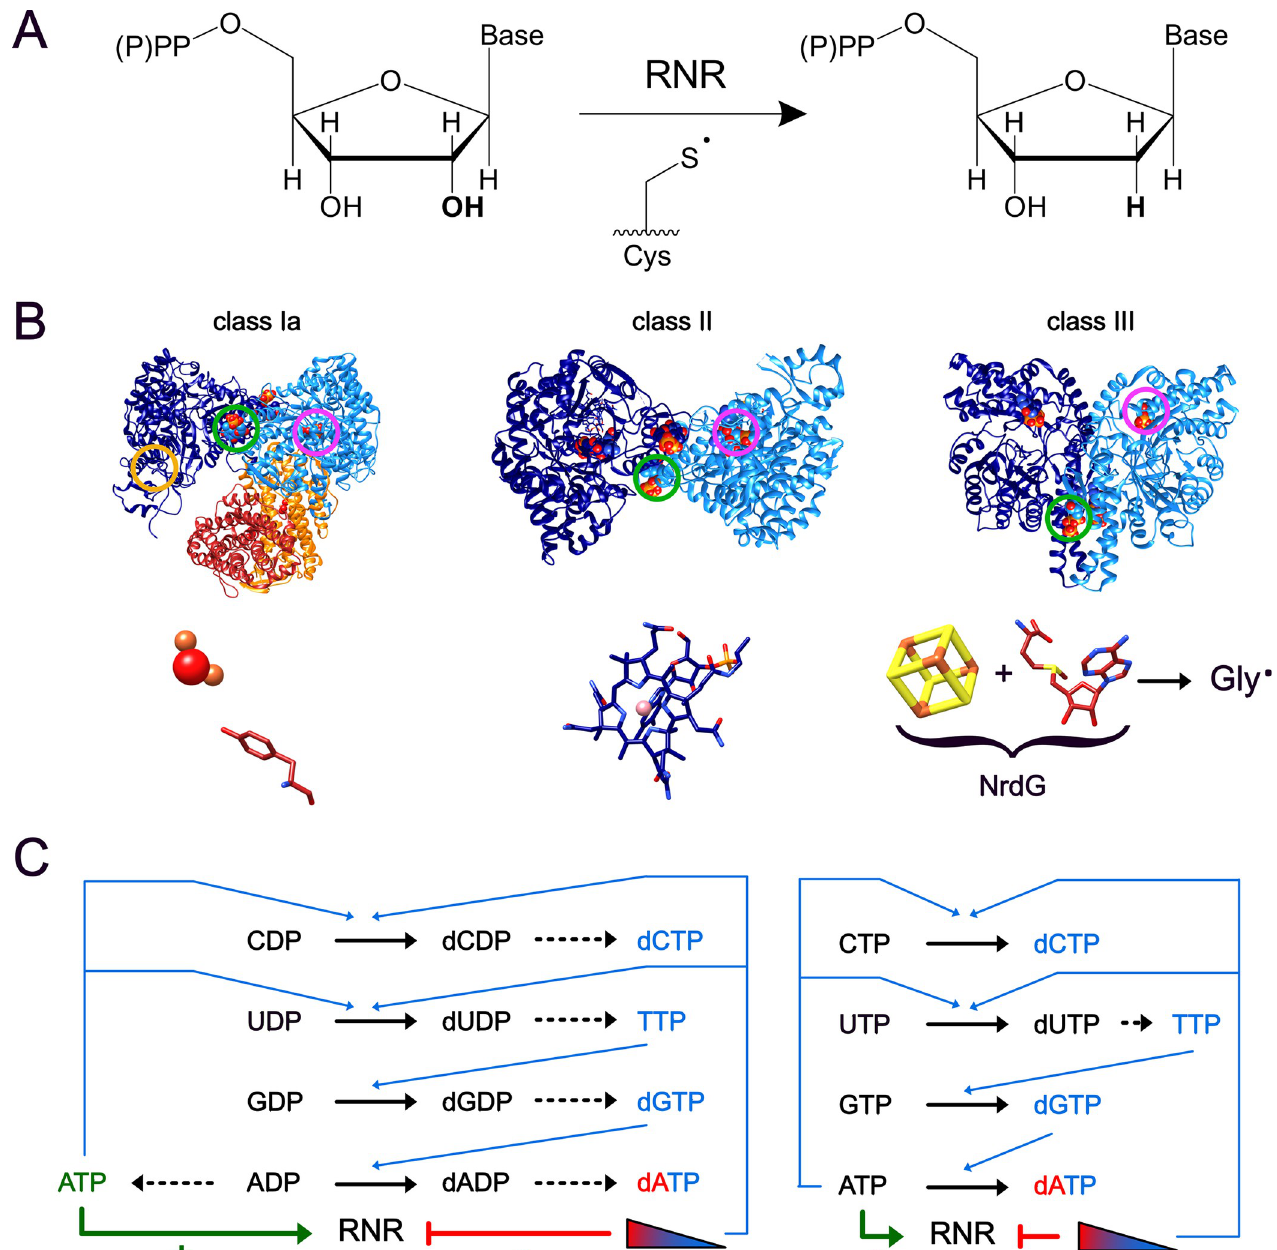
Fig 1. An overview of the ribonucleotide reductase reaction, classes, and allosteric regulation. (A) Ribonucleotide reductase catalyzes the conversion of ribonucleotide di- or triphosphates to their corresponding deoxyribonucleotide via a catalytic cysteine radical. (B) Examples of class I, class II, and class III enzymes with their corresponding metallocofactors and radical harbors. In each structure, one specificity effector site is circled in green and one substrate site is circled in magenta. The E . coli class Ia RNR (left) is shown in the active form with the catalytic subunits (NrdA) shown in blue and the radical-generating subunits (NrdB) shown in orange/red (PDB 6W4X) [52]. Bound nucleotides (GDP substrate and TTP specificity effector) are shown as spheres. The activity effector site, which does not have any bound nucleotide in this structure, is circled in orange. The diiron-oxo center and tyrosyl radical shown below the structure are found in the radical-generating subunit and are specific to class Ia RNRs; see Table 1 for the radical harbors of other subclasses of class I RNRs. The Thermotoga maritima class II RNR (NrdJ; middle) is shown with the bound nucleotides (GDP substrate and TTP specificity effector) shown as spheres (PDB 3O0O) [34]. The S -adenosylcobalamin (B 12 ) cofactor found in each subunit is shown as sticks and is highlighted below the structure. The Escherichia coli T4 bacteriophage class III RNR (NrdD; right) is shown with bound nucleotides (dGTP) shown as spheres (PDB 1HK8) [85]. The activase NrdG is structurally uncharacterized and contains the 4Fe-4S cluster shown below the structure. NrdG in complex with S- adenosylmethionine generates a glycyl radical is generated on the catalytic subunit via a transient interaction. (C) Allosteric regulation of RNRs that use NDPs (left) or NTPs (right) as substrates. Following